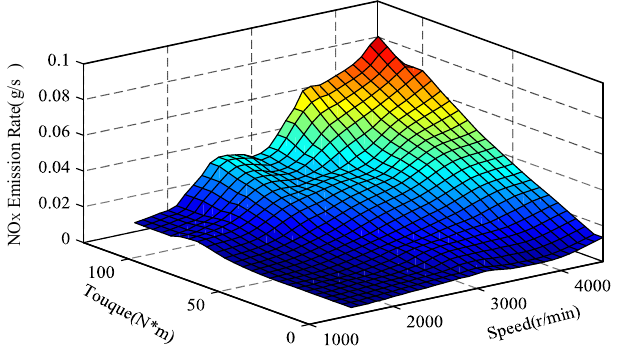
Figure 2 . Engine fuel consumption map. Figure 2. Engine fuel consumption map.